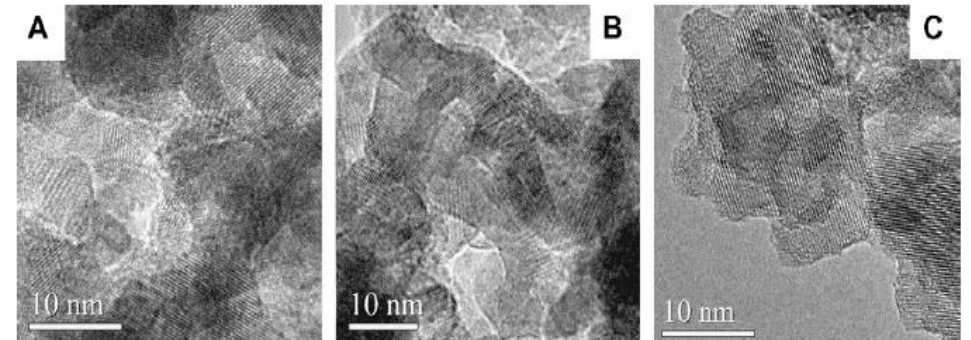
Figure 16. High Resolution TEM (HRTEM) images of three mesoporous TiO ( A ) Film 1; ( B ) Film 2; and ( C ) Film 3. Scale bar is 10 nm. Reprinted with permission from [47]. Copyright 2008